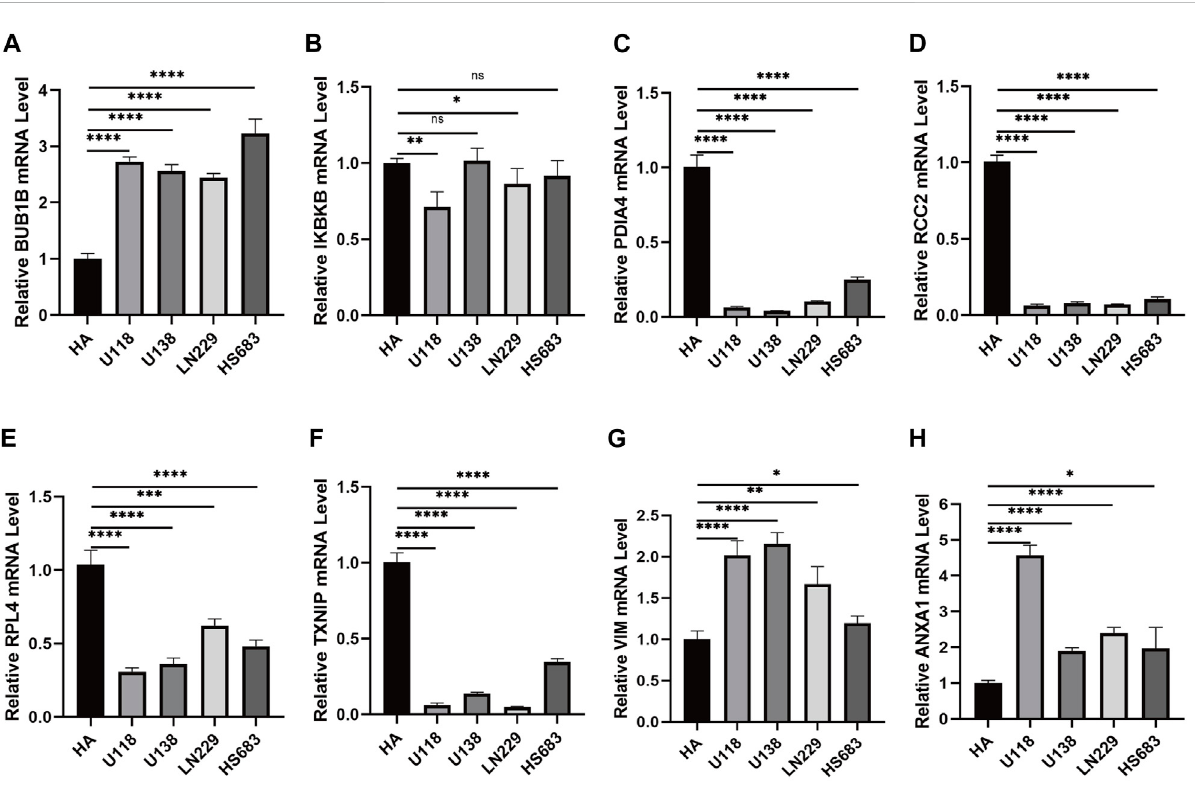
FIGURE 9 (A) Relative mRNA expression of BUB1B in different glioma cell lines. (B) Relative expression of IKBKB mRNA in different glioma cell lines. (C) Relative expression of PDIA4 mRNA in different glioma cell lines. (D) Relative expression of RCC2 mRNA in different glioma cell lines. (E) Relative expression of RPL4 mRNAindifferentglioma celllines. (F) Relative expression of TXNIP mRNAindifferentglioma celllines. (G) Relative expression of VIM mRNAindifferentglioma celllines. (H) Relative expression of ANXA1 mRNAindifferentgliomacell lines. * p < 0.05, ** p < 0.01, ***p < 0.001, and ****p <